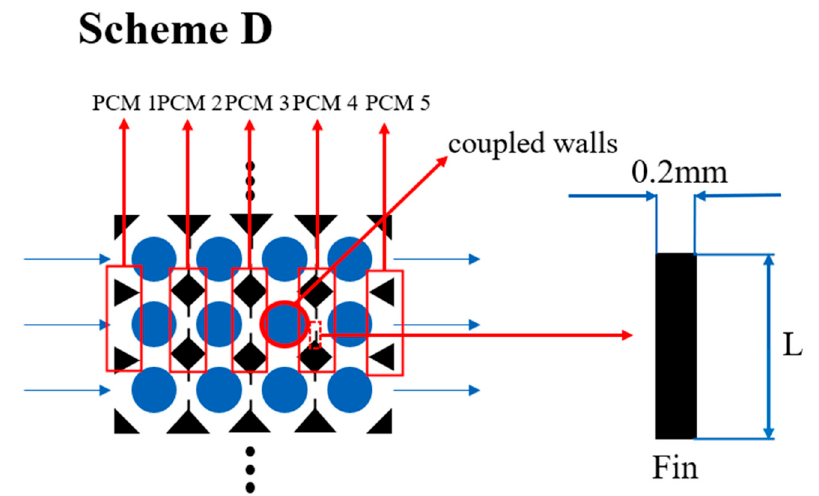
Figure 3. Outer fin scheme (scheme D).